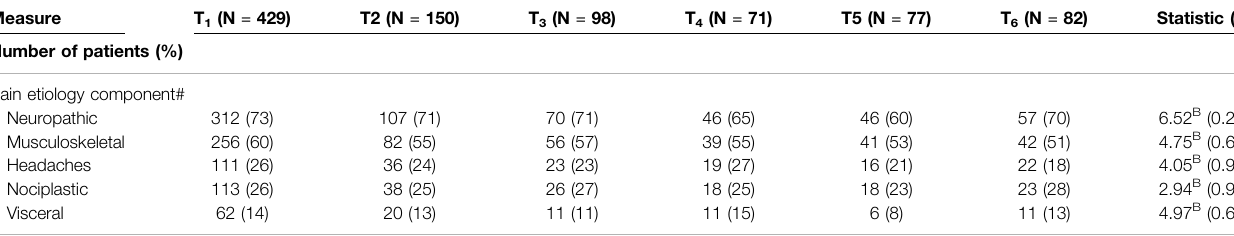
TABLE 2 | Pain etiology characteristics of the study sample at one month intervals within a six-month period.